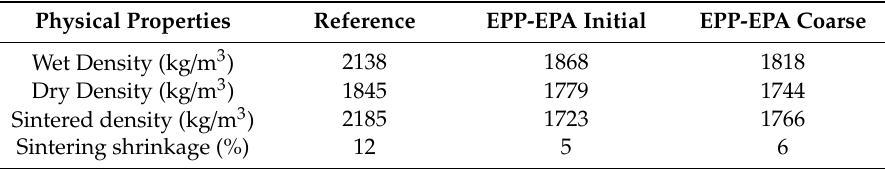
Table 6. Physical properties of sintered